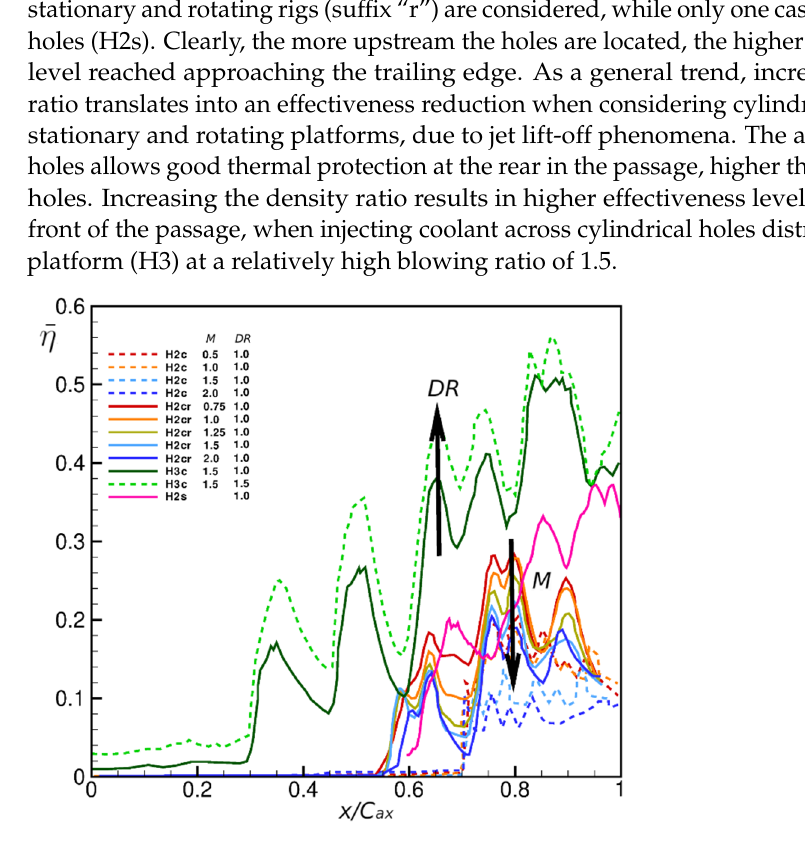
Figure 11. Platform rotor blade film cooling effectiveness as a function of operating conditions—data reproduced: H2c from [19], H2cr from [30], H3c from [15], H2s from [26].